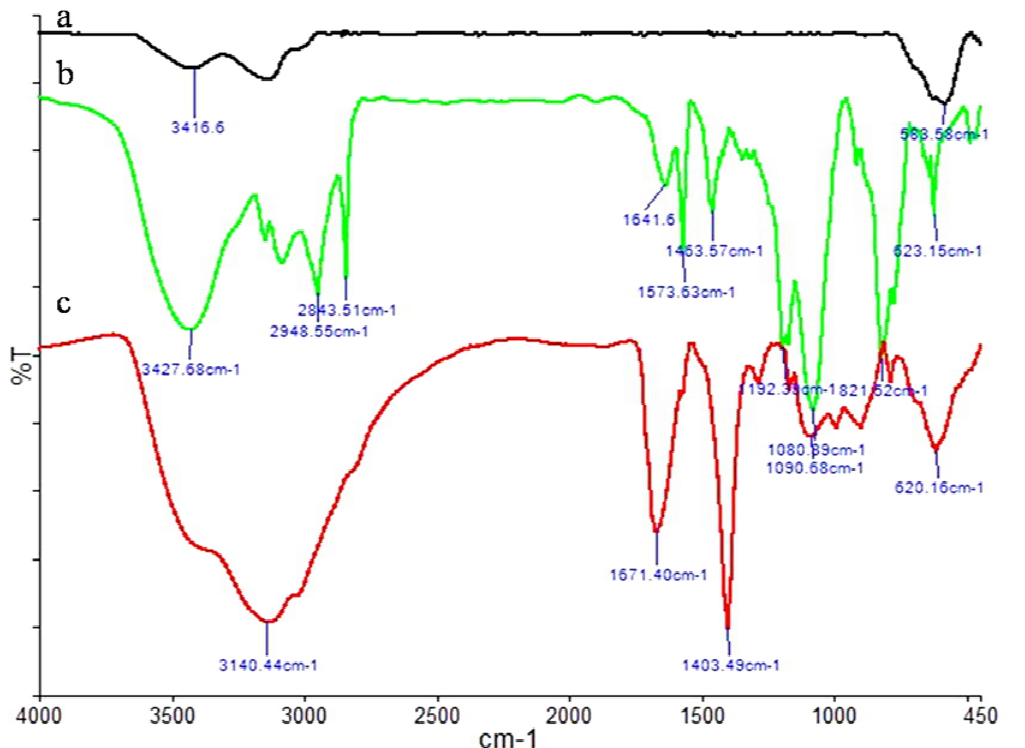
Fig. 1. FT-IR spectra of (a) MNP, (b) IL, (c) Si-Im-HSO